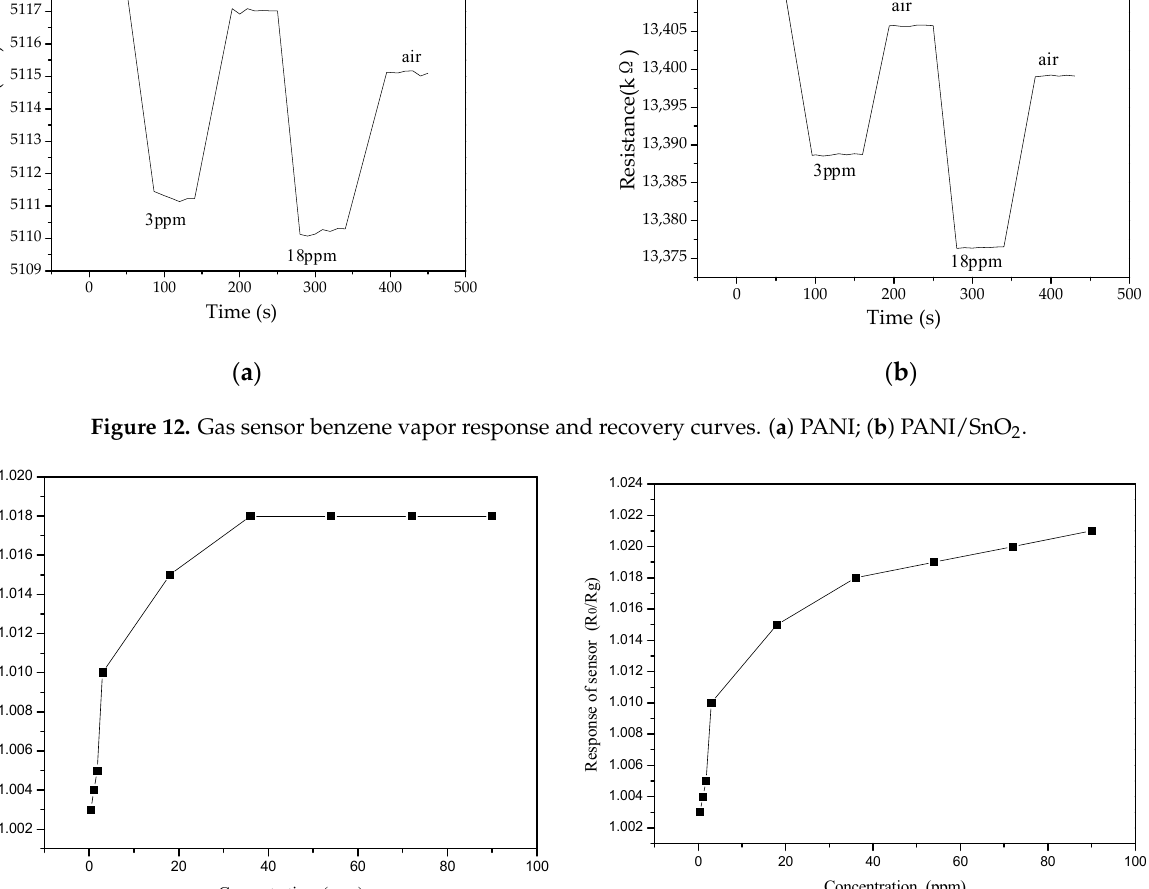
Figure 13. Gas sensor response curves with benzene vapor concentration. ( a ) PANI; ( b ) PANI/SnO 2 .